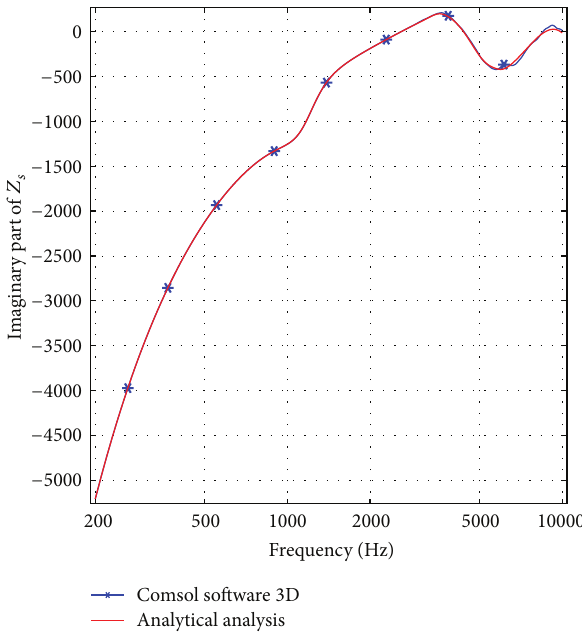
Figure 2: Imaginary part of surface impedance.